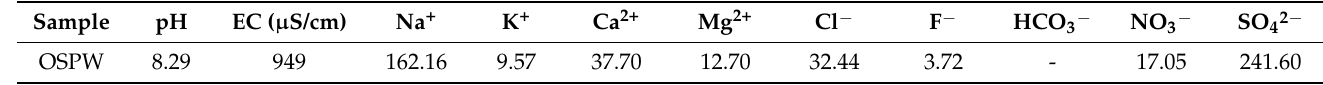
Table 4. The water analysis of OSPW: pH, EC, and major cations and anions (unit is